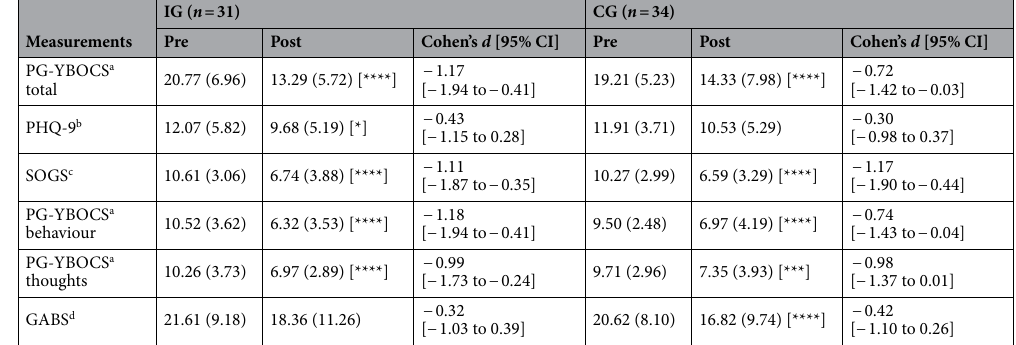
Table 2. Within-group differences across time of complete cases with means, standard deviations, effect sizes in Cohen’s d and 95% confidence intervals. [*] = p ≤ .05; [**] = p ≤ .01; [***] = p ≤ .005; [****] = p ≤ .001. a Pathological Gambling Adaptation of Yale-Brown Obsessive Compulsive Scale. b PHQ-9: Patient Health Questionnaire–9. c South Oaks Gambling Screen. d Gambling Attitudes and Beliefs